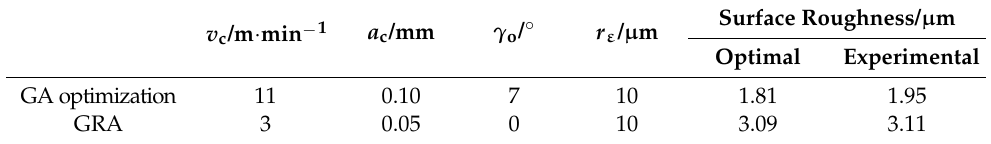
Table 6. Optimal cutting parameters and machined surface roughness at different optimization